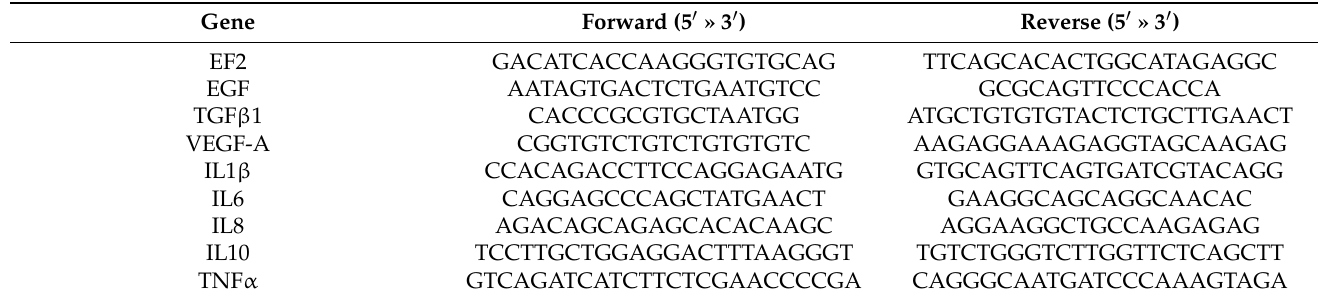
Table 3. Oligonucleotides used for real-time